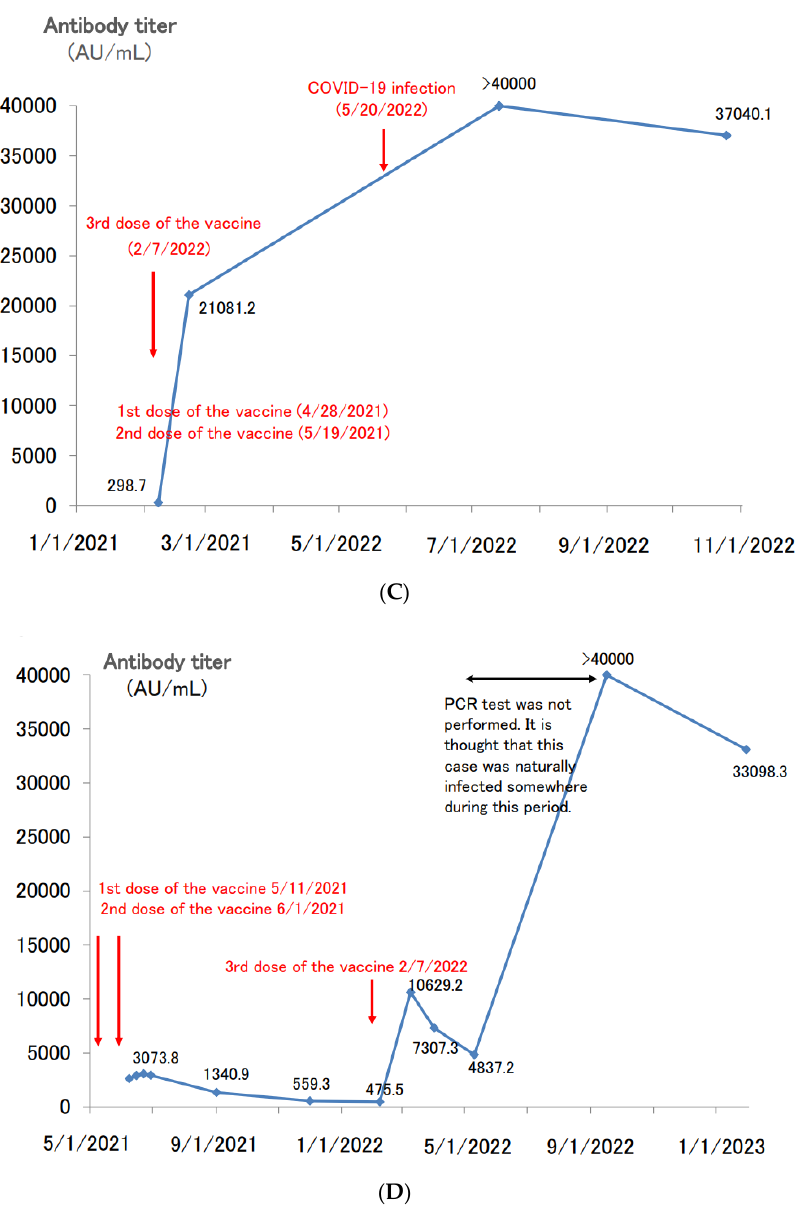
Figure 5. ( A ). Longitudinal change of the SARS-CoV-2 antibody titer of a 41 year-old male. ( B ) Longitudinal change of the SARS-CoV-2 antibody titer of a 65 year-old male. ( C ) Longitudinal change of the SARS-CoV-2 antibody titer of a 39 year-old female. ( D ) Longitudinal change of the SARS-CoV-2 antibody titer of a 60 year-old male.